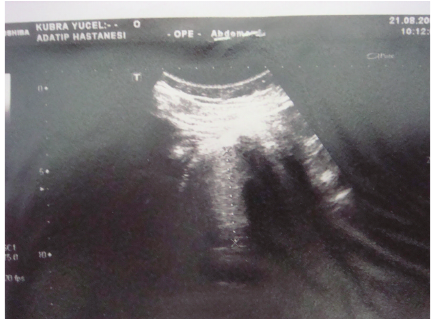
Figure 1: (Ultrasonographic (USG) examination): the lesion well- defined, solid, hyperechoic mass of pancreatic head-body, measur- ing 5×5 cm. No infiltration into the intra-abdominal organs is seen.